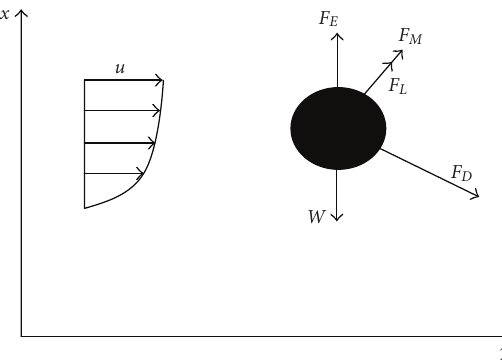
Figure 1: Forces acting on a saltating particle.